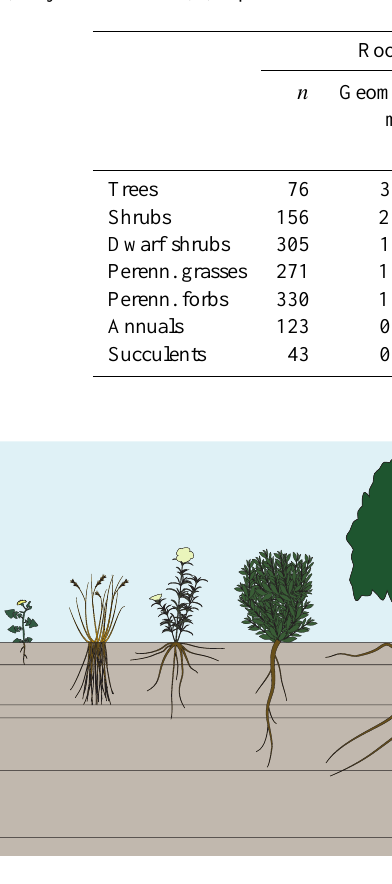
Table 1. Absolute root dimensions (geometric means) for maximum rooting depths and lateral root spreads for seven plant growth forms in water-limited ecosystems worldwide. Geometric means marked by different letters are significantly different at p< 0 . 05 according to one-way ANOVA (analysis of variance) (adapted from Schenk and Jackson, 2002a).